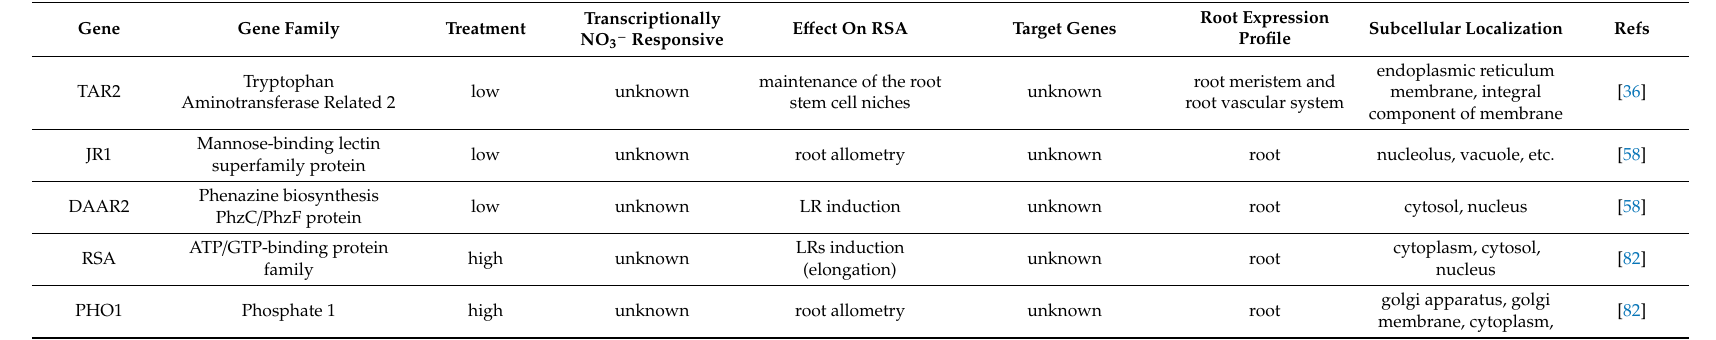
Table 4. Unknown A ffi nity Nitrate Responsive